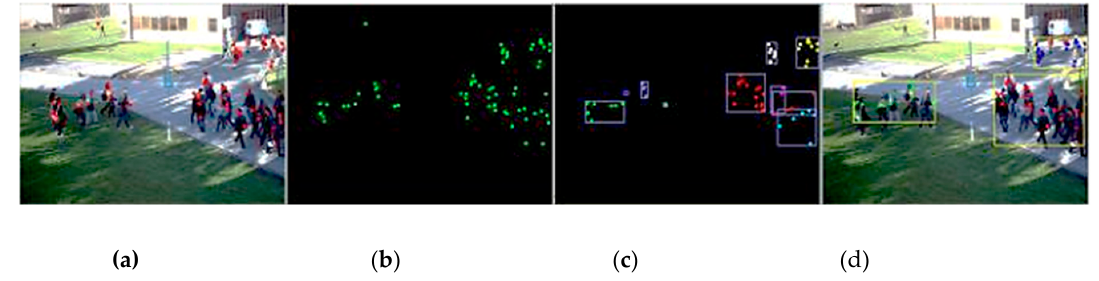
Figure 2. The proposed model of two-stage clustering presented in [16]: ( a ) the detected feature points; ( b ) the feature points shown without the background; ( c ) clusters obtained after applying first-stage clustering; ( d ) clusters obtained using the adjacency matrix-based clustering (AMC)